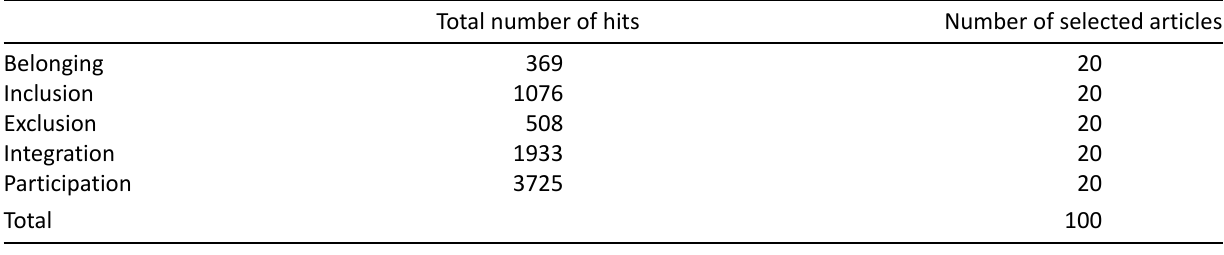
Table 1. Number of hits and number of selected